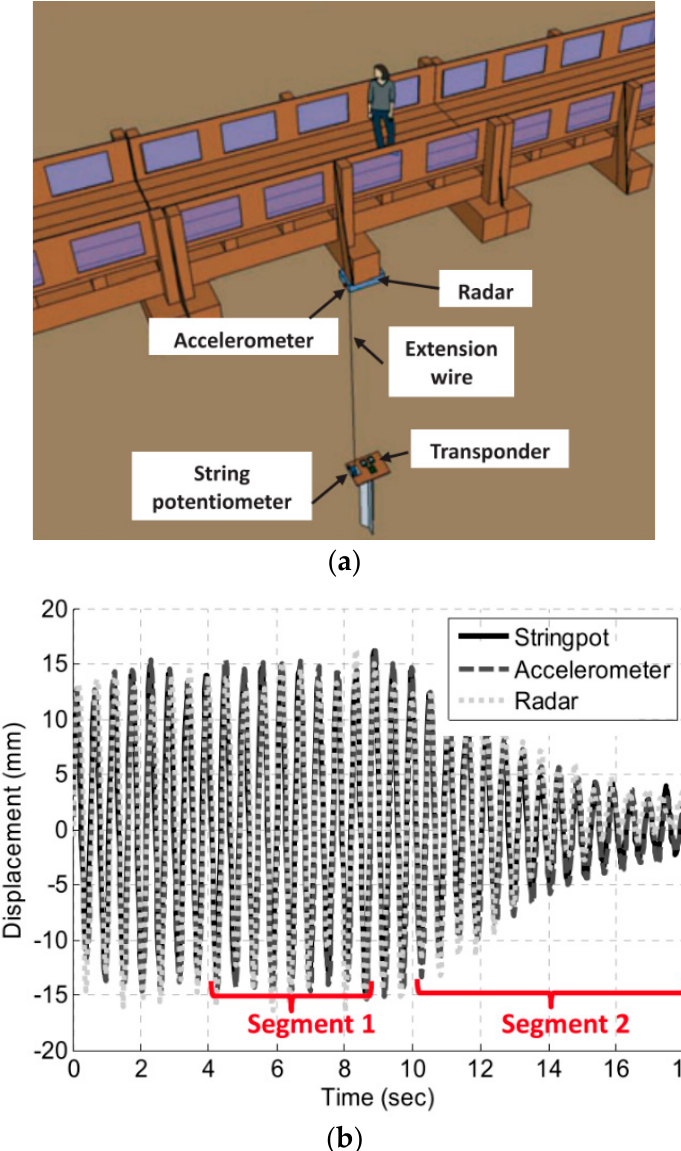
Figure 3. SHM of a bridge based on Doppler radar on active backscattering configuration: ( a ) experimental setup; ( b ) displacement measurements retrieved by all the sensors. Reprinted with permission from ref. [64]. Copyright 2016 John Wiley and Sons.